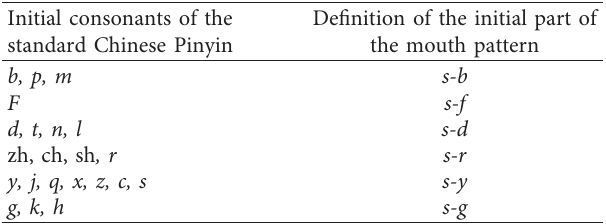
Table 1: Conversion table for the initial consonants of the standard Chinese Pinyin.